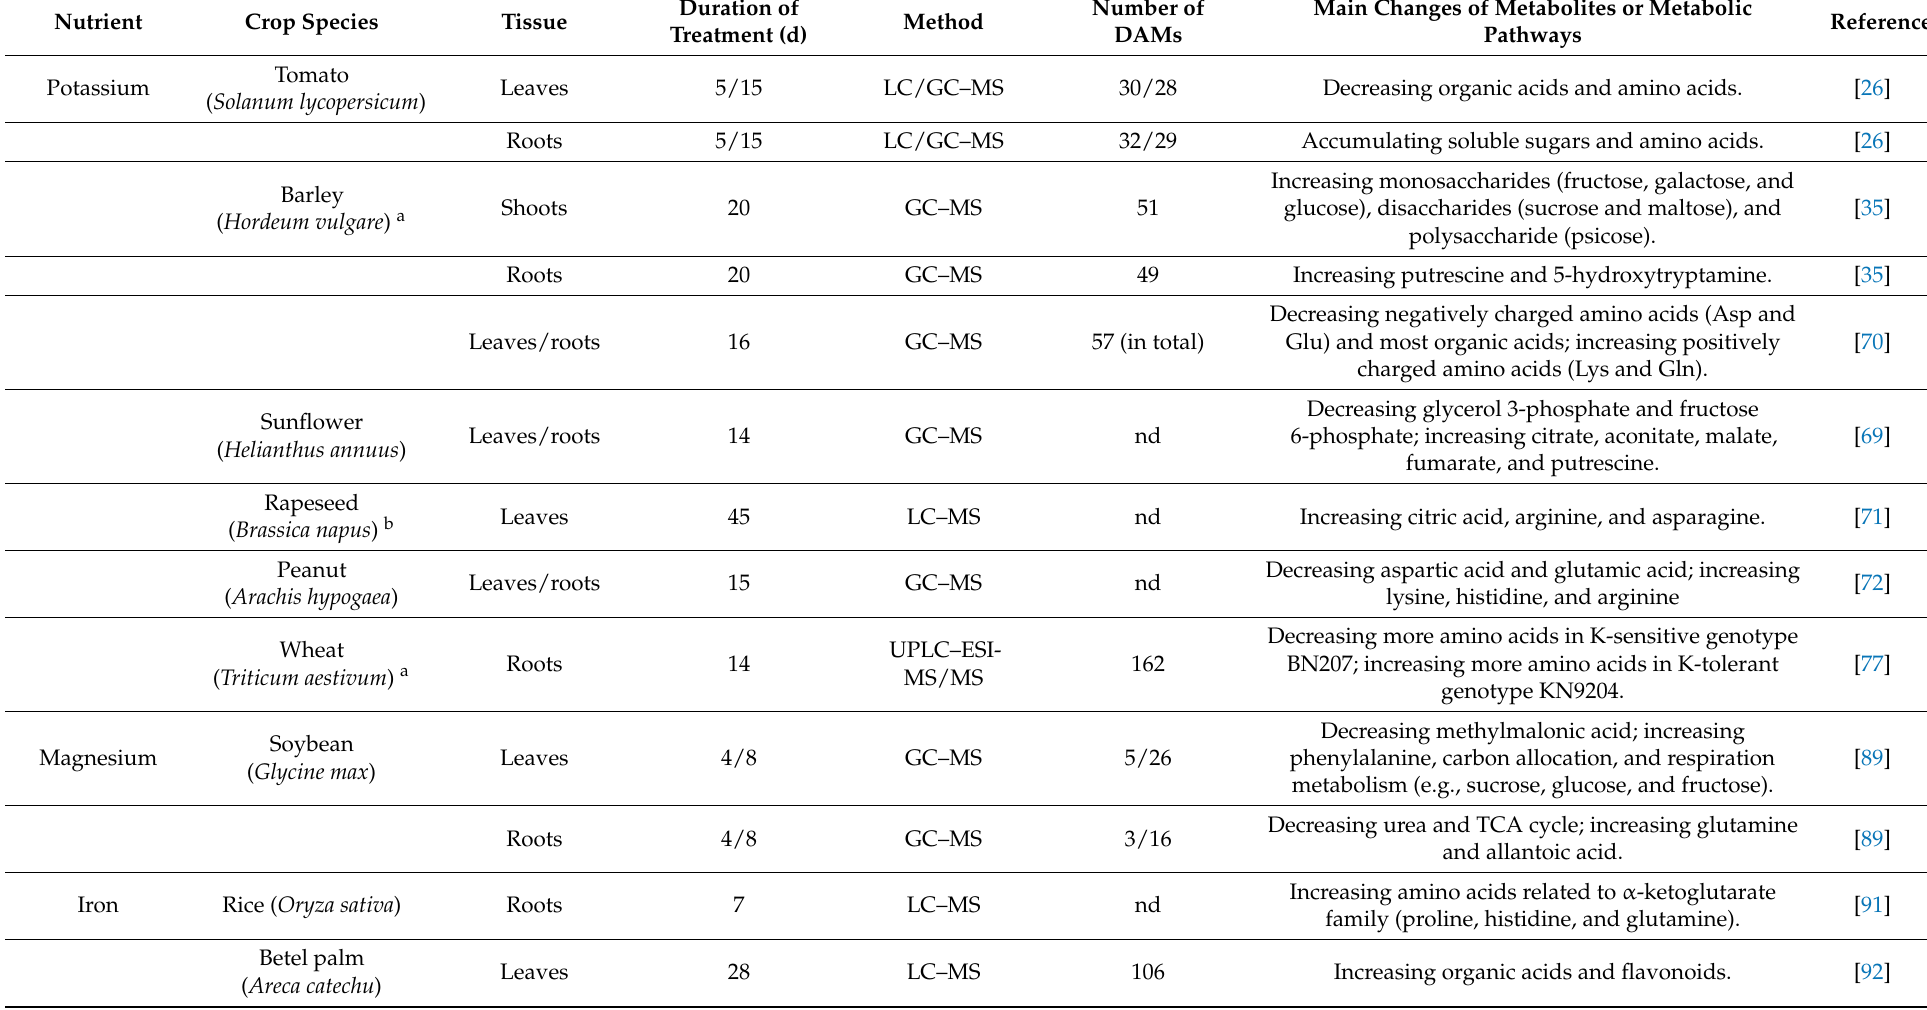
Table 3. Metabolome analyses of crop responses to other nutrient